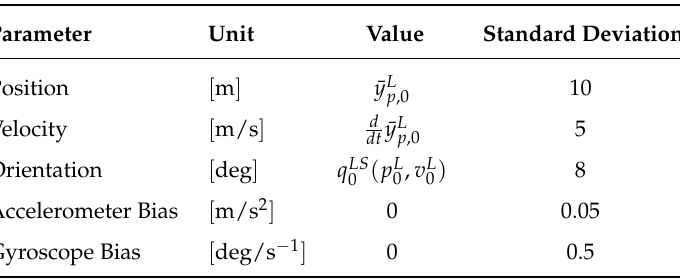
Table 2. Parameters of MHE algorithm defining the initial